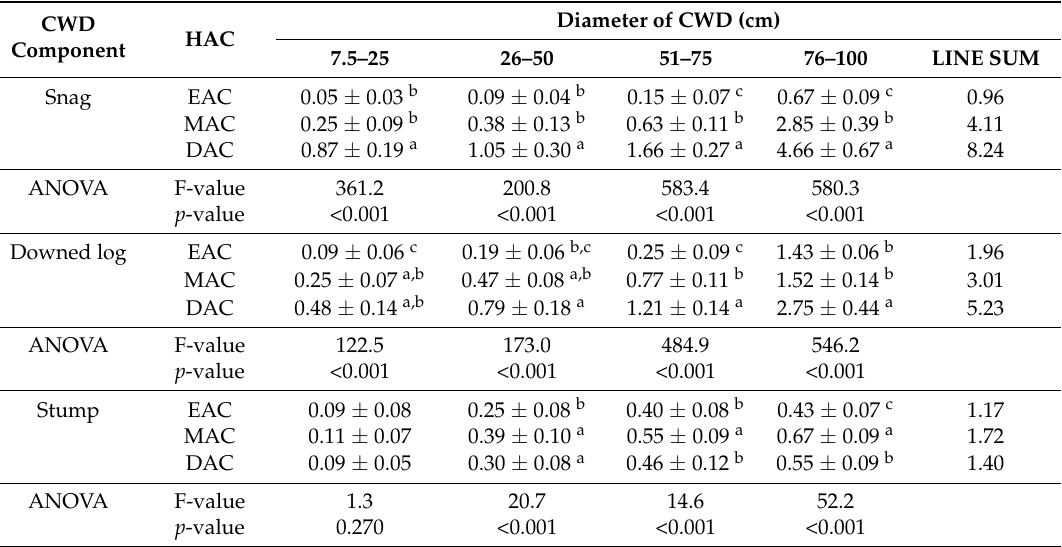
Table 8. Volume (average ± SD) of CWD (m 3 ha − 1 ) in diameter classes and accessibility classes; results of ANOVA and Tukey HSD tests 1